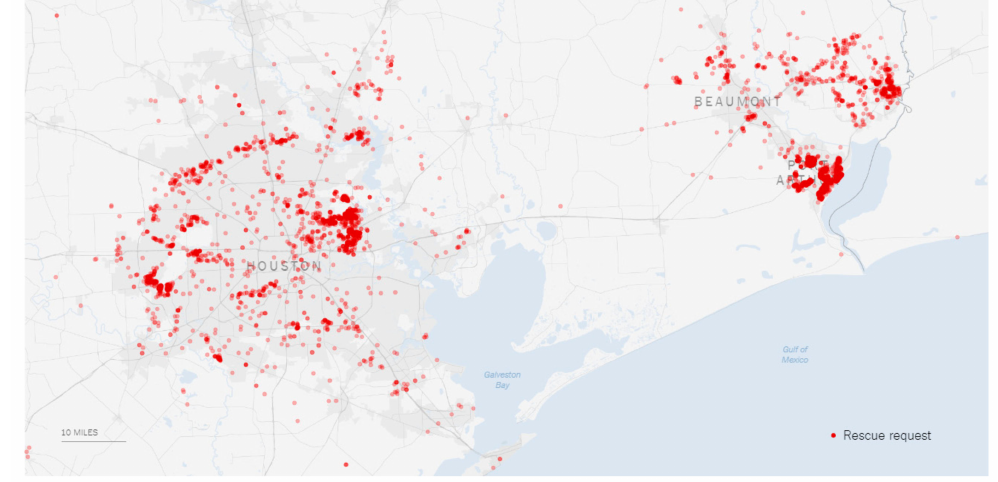
Figure 13. Rescue requests of inhabitants in Beaumont and Houston [179].